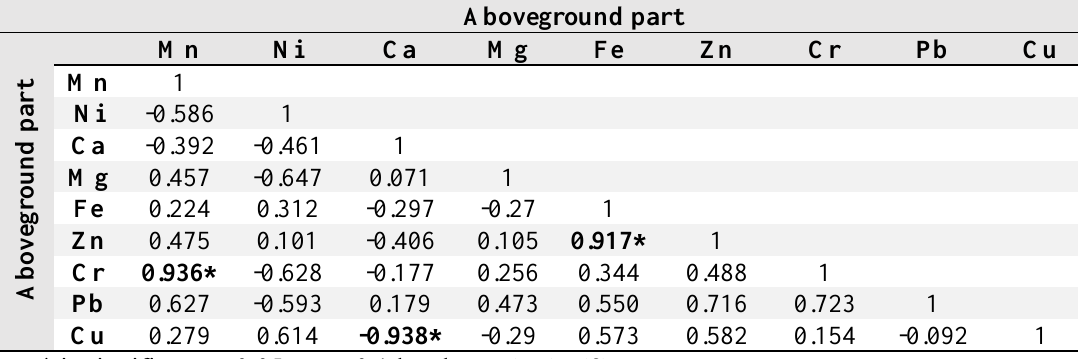
Table 5. Pearson's correlation between heavy metals at the aboveground part of Rumex acetosella. Aboveground part